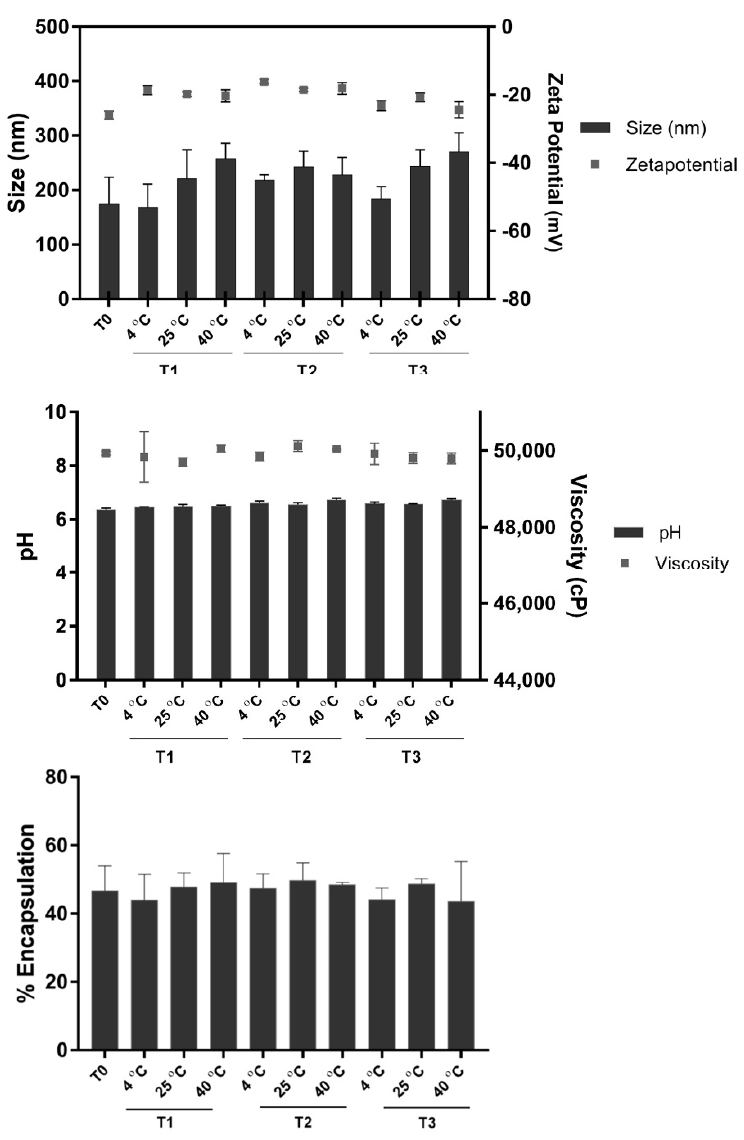
Figure 4. Stability data of LNF over 3 months (mean ± SD), in term of size, zeta potential, pH, viscosity, and % encapsulation of fenugreek